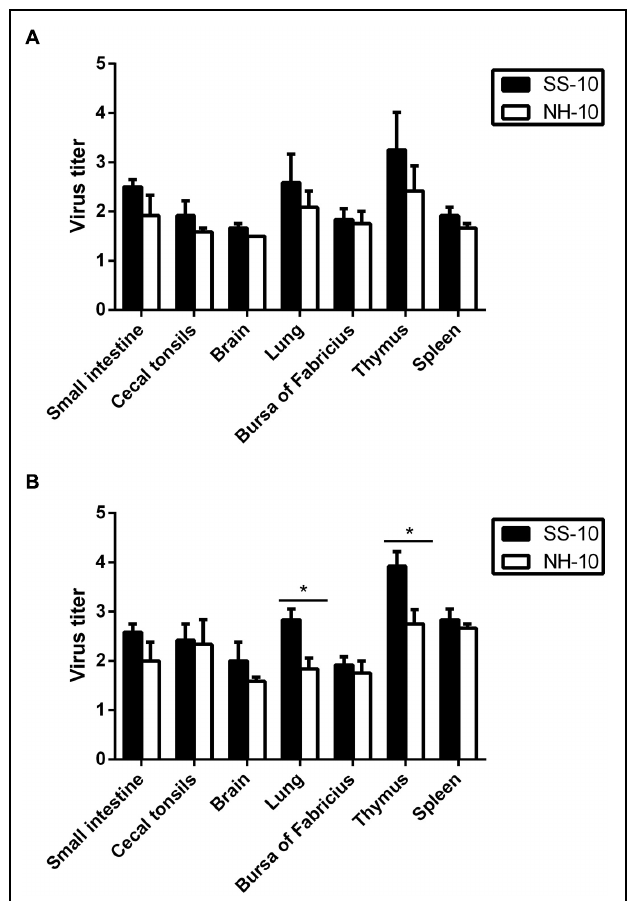
FIGURE 1 | Replication in Peking ducks of Newcastle disease virus (NDV) after inoculated intranasally. Healthy 2-week-old Peking ducks were inoculated with 0.2 ml 10 6 EID 50 of the selected virus via intranasal routes. Virus titers in Peking ducks at 24 and 48 h post inoculation (hpi). (A) 24 hpi; (B) 48 hpi. For statistical analysis, a value of 1.5 was assigned if the virus was not detected from the undiluted sample in three embryonated hen eggs. Virus titers are expressed as means ± standard deviation in log 10 EID 50 /g of tissue. Significance was evaluated with two-tailed Student’s t -test ( ∗ p < 0.05).